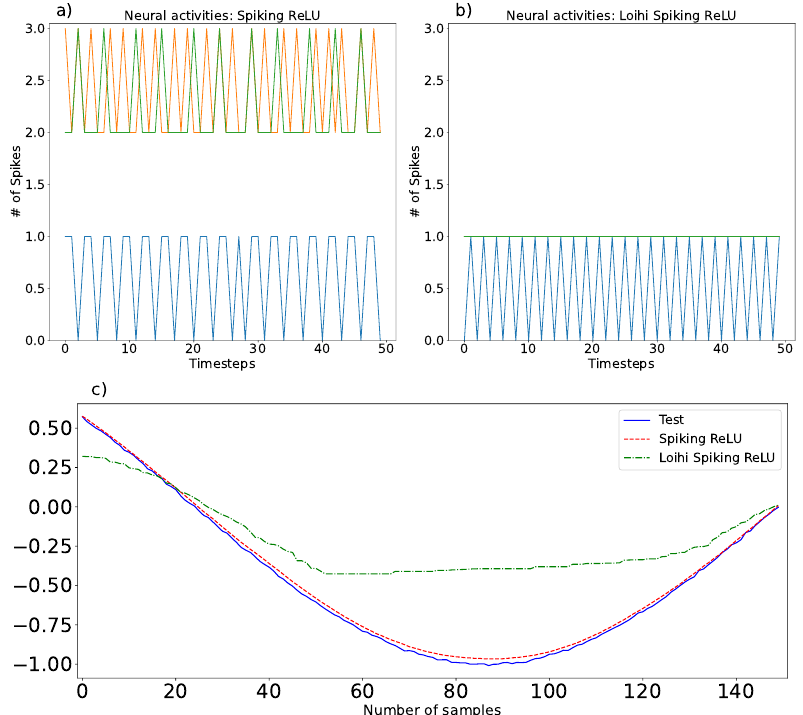
Figure 3. ( a ) Neural activities using a spiking ReLU activation for inference (one input vector is shown to the network during 50 timesteps), ( b ) neural activities using the discretized version of the spiking ReLU activation, and ( c ) predictions over the testing